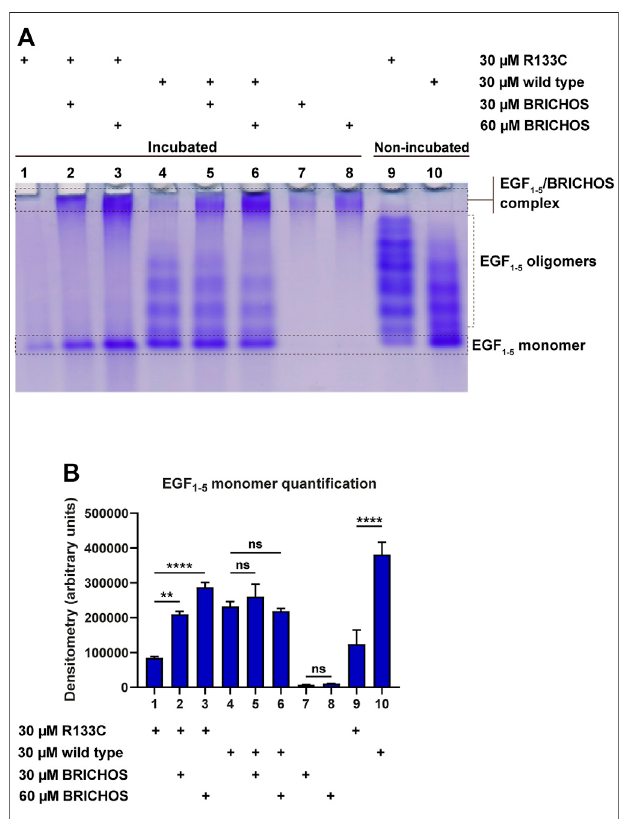
FIGURE 4 | Native SDS-PAGE analysis of puri fi ed WT and R133C mutant N3 EGF 1 – 5 proteins with and without Bri2 BRICHOS incubation. (A) The puri fi ed wildtype N3 EGF 1 – 5 and R133C mutant proteins were incubated with and without Bri2 BRICHOS at 37 ° C for 80 h, and the fi nal products were analyzed by native PAGE. The native SDS-PAGE is a representative image of three independent experiments. (B) The monomers of the EGF 1 – 5 protein were quanti fi ed from three independent gels using Image Studio. The densitometry values are represented as arbitrary units, and error bars represent SD. Statistical analysis was evaluated by one-way analysis of variance (ANOVA) followed by ordinary one-way ANOVA and followed by Bonferroni ’ s multiple comparisons test. p < 0.05 was considered signi fi cant (* p < 0.05, ** p < 0.01, *** p < 0.001, **** p < 0.0001).